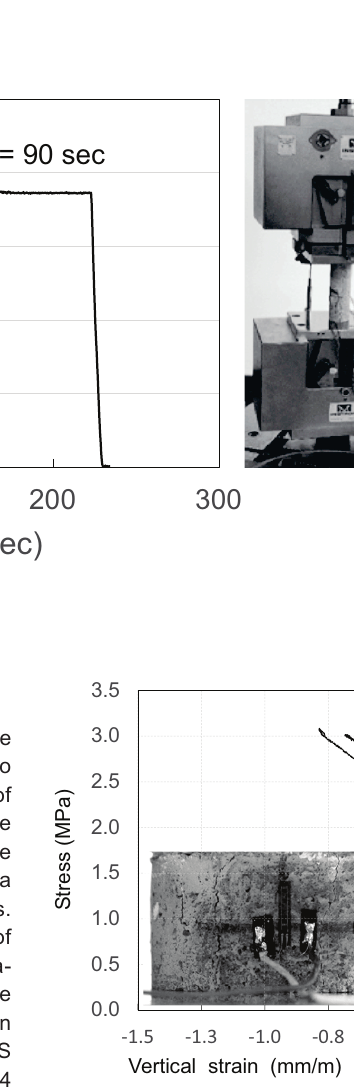
Figure 17 Stress-strain response for samples with a d/h ratio of 1.75